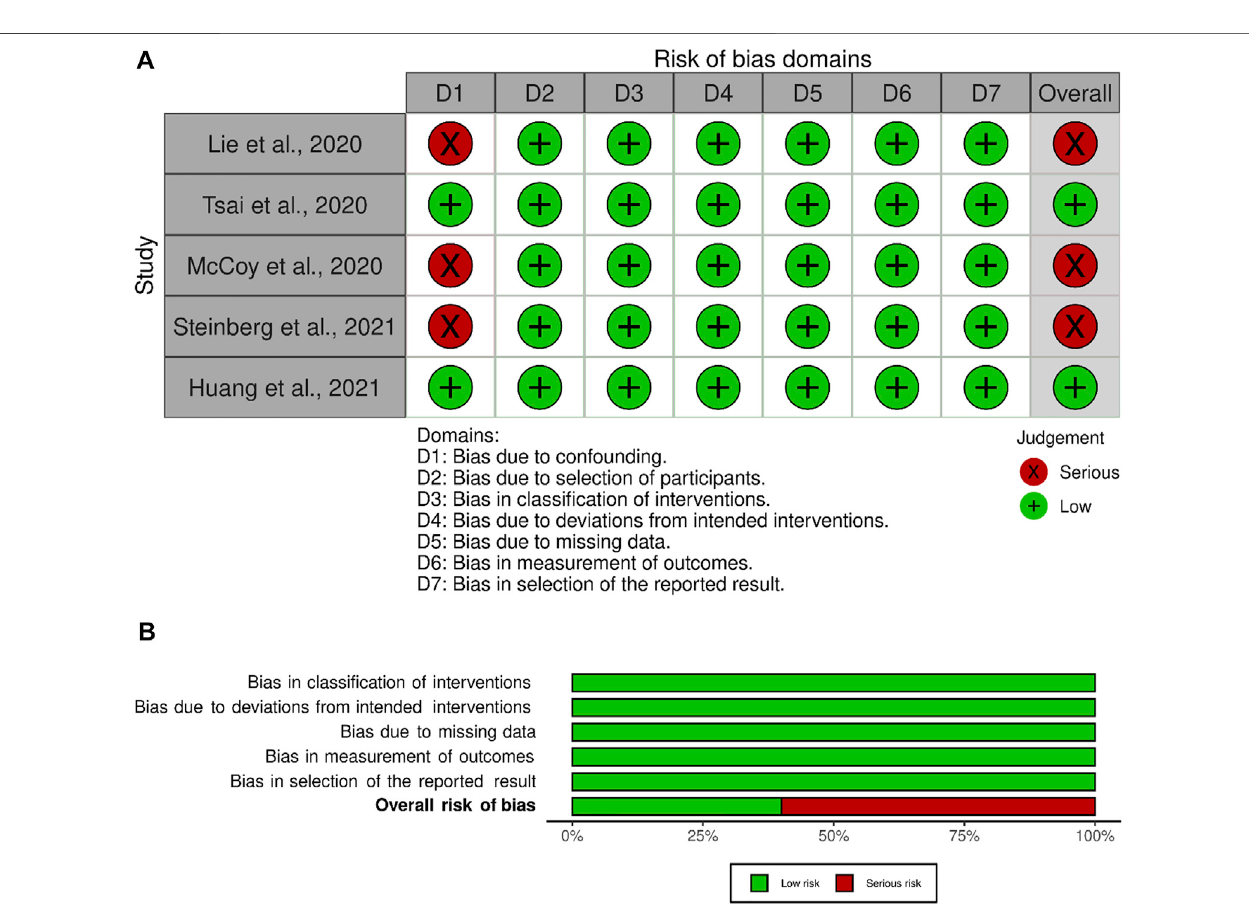
Frontiers in Aging |